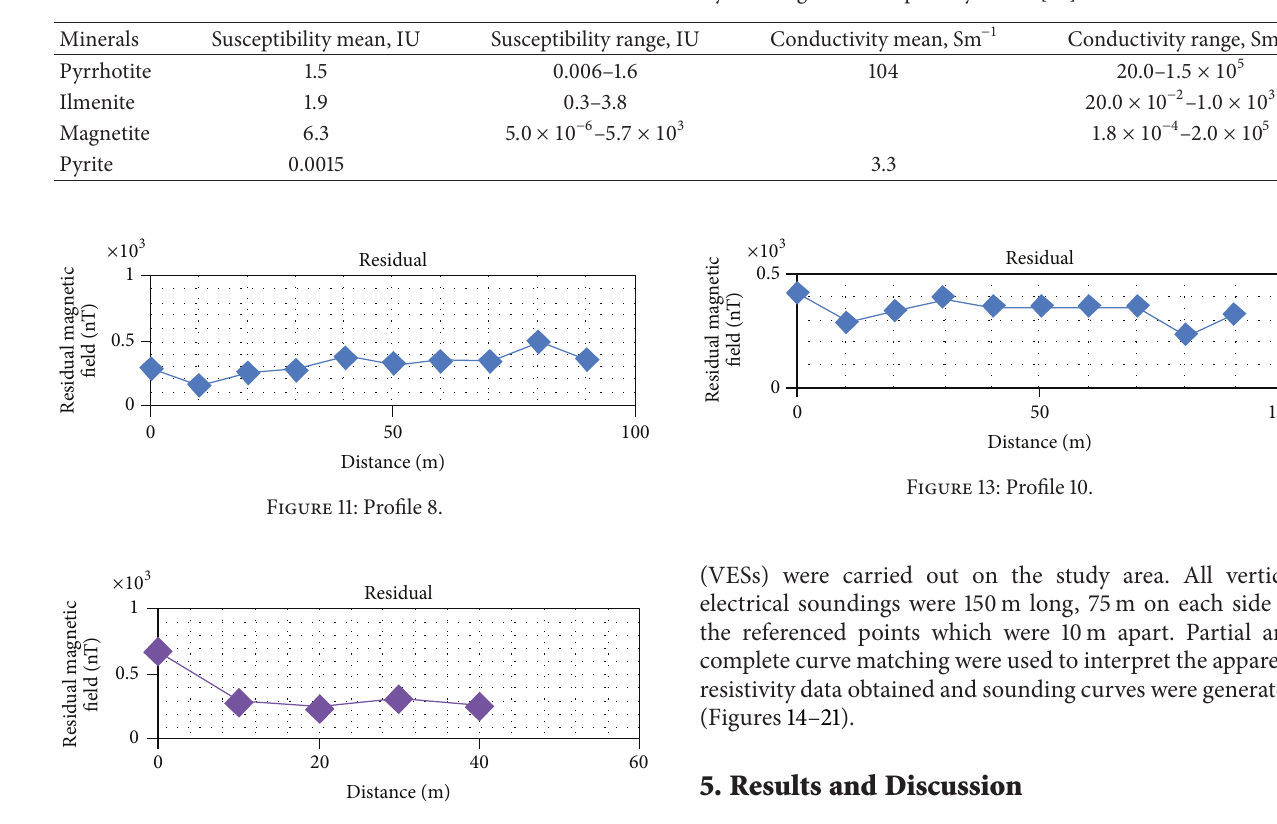
Table 1: Common minerals electrical conductivity and magnetic susceptibility values [26].